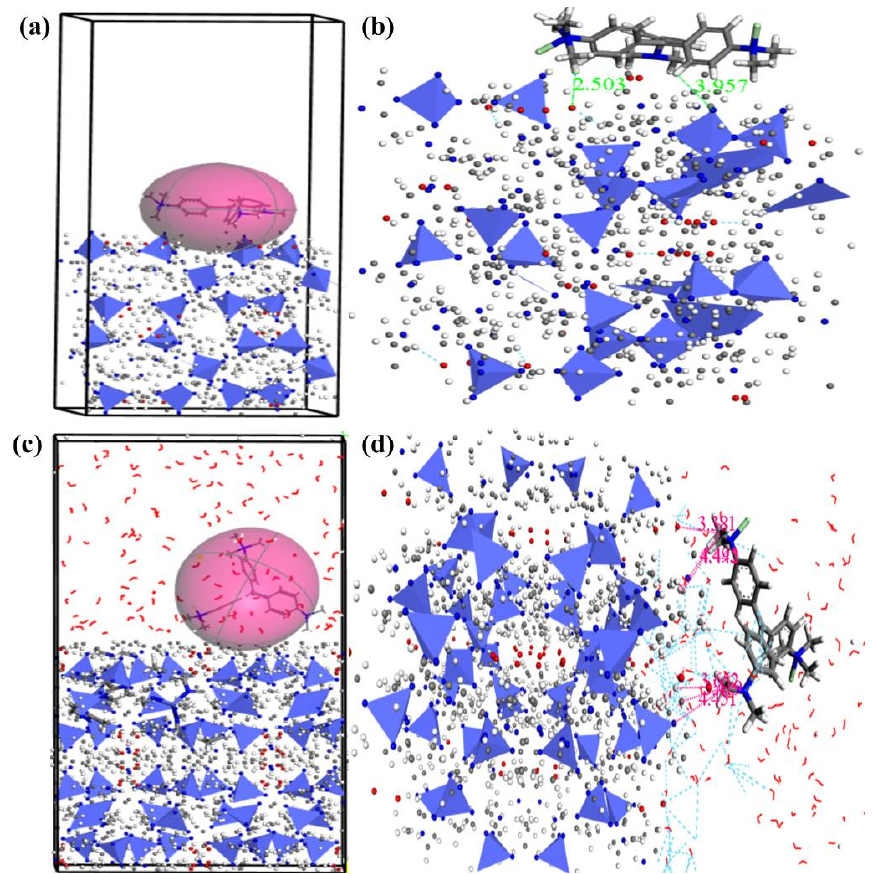
Figure 6. The lowest-energy configurations of MG molecule on the ZIF-67 surface ( a , b ) in a dry system. MD snapshots of adsorption of MG molecule on the ZIF-67 surface ( c , d ) in water. The bond length is in Angstroms, the MG is displayed in polyhedron style for the purpose of clarity. Table 2. Comparison of the MG removal rates of different MOFs’ adsorption capabilities.